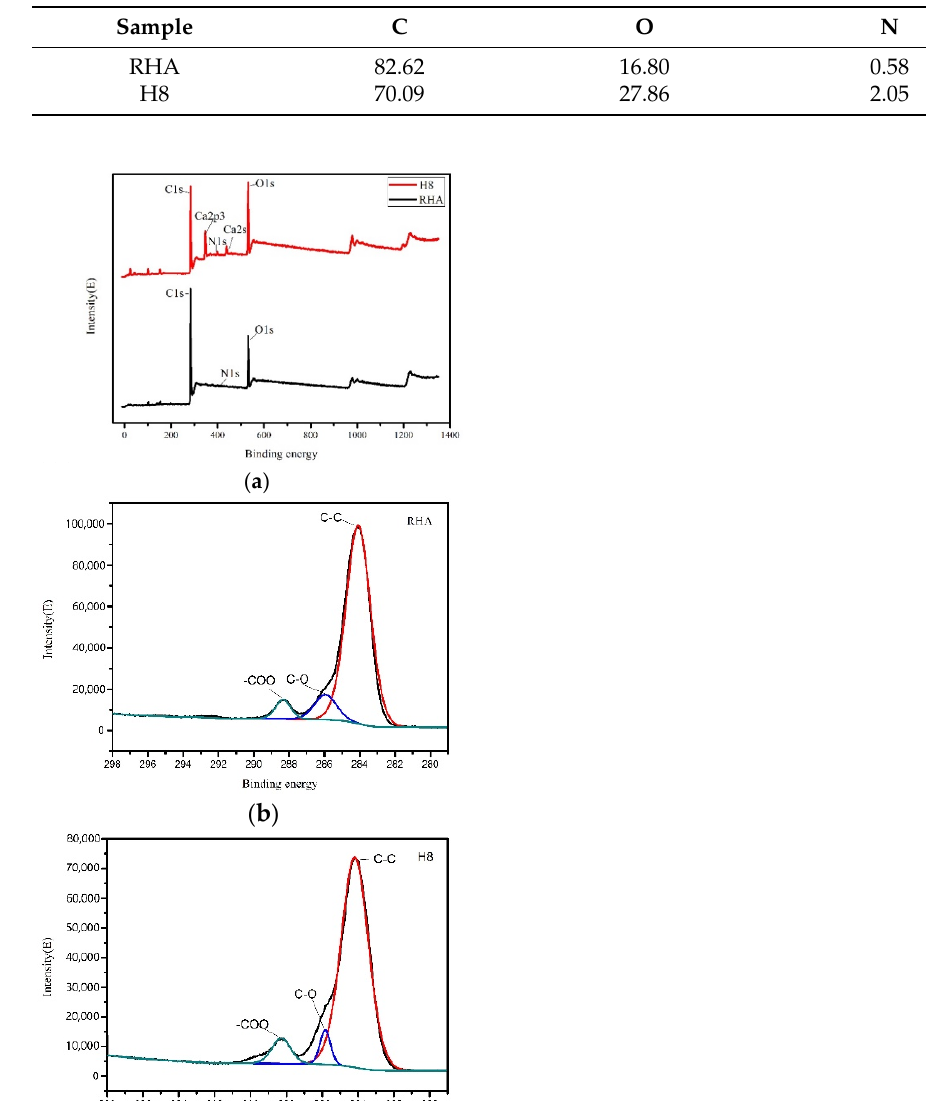
Table 4. Relative contents of elements on the surface of absorbents.